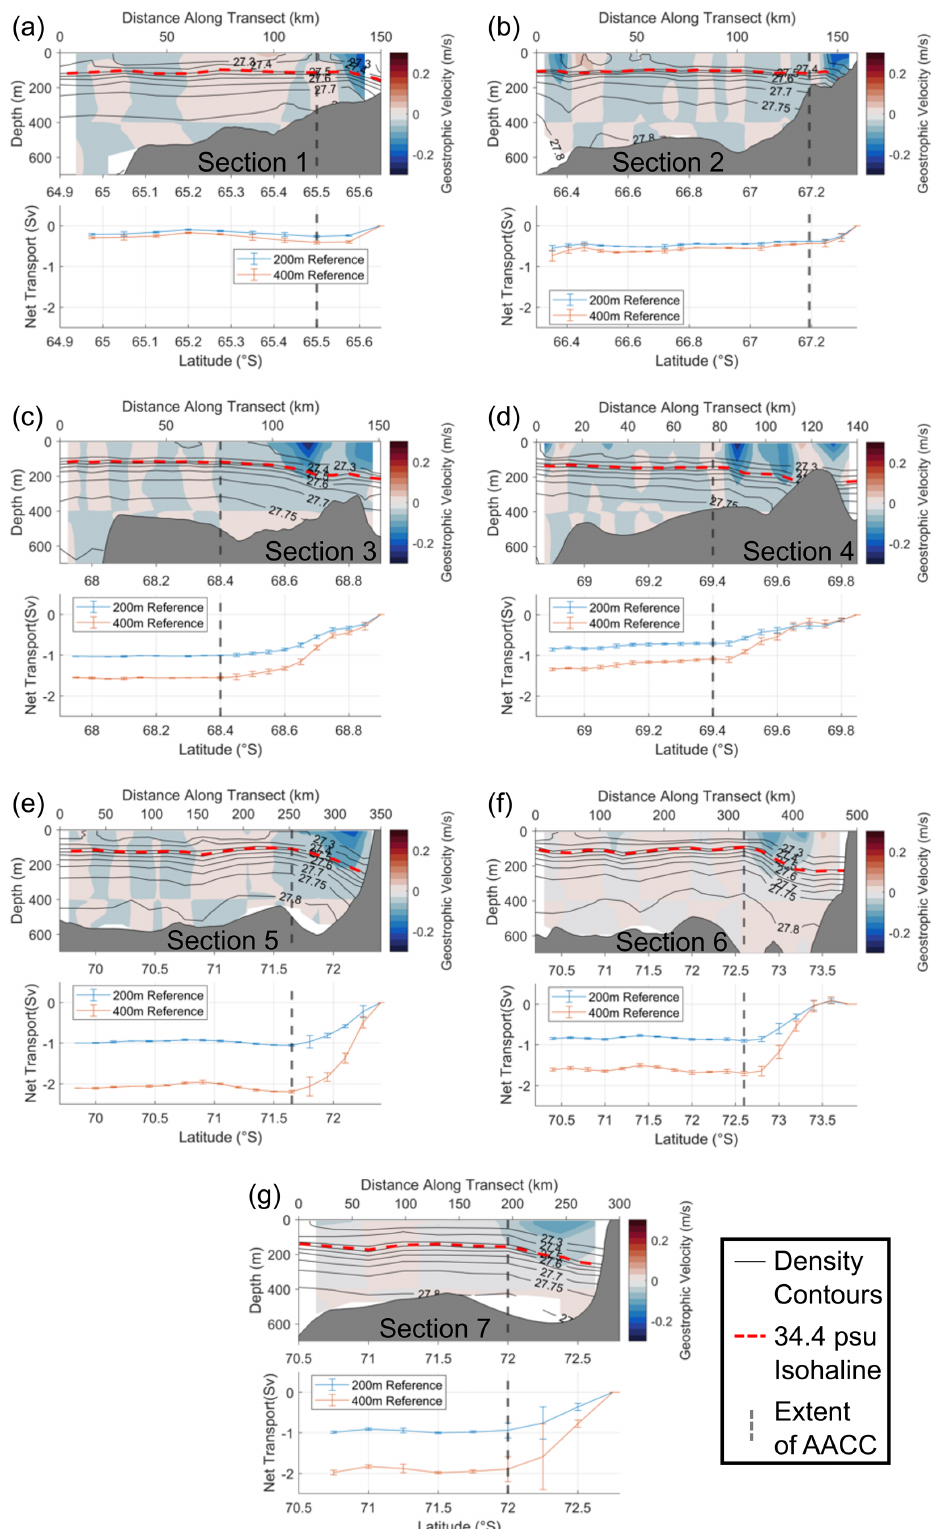
Figure 9. Geostrophic velocity (meters per second – ms − 1 ; referenced to 400m; top) and geostrophic transport (Sv; bottom) for all sections in Fig. 3. Transport values are given for both the 200 and 400m reference level, and transports are cumulative from the coast and calculated by integrating from the surface to the 34.4psu isohaline (red dashed curve). Negative (positive) values indicate westward (eastward) transport and